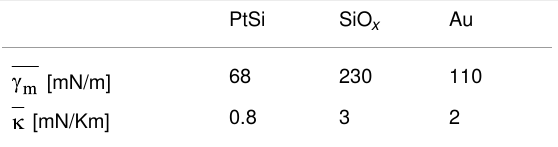
Table 2: Average values and range of γ and κ for PtSi, SiO x , and Au tip